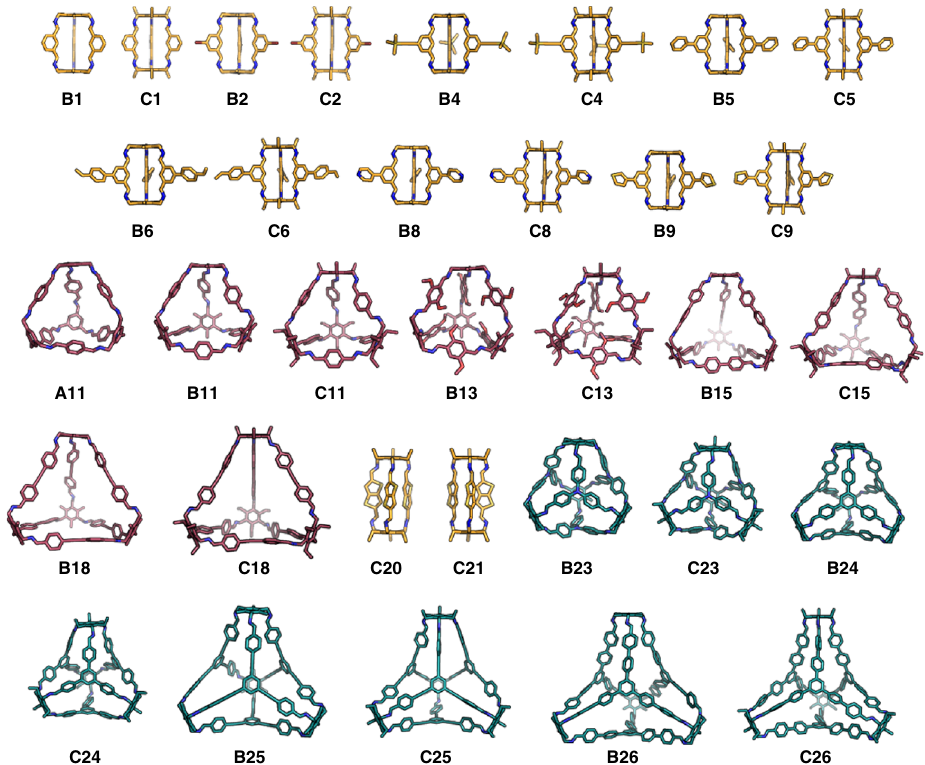
Fig. 4 The 33 cages that formed cleanly in this high-throughput study. Tri 2 Di 3 cages are shown with orange carbons, Tri 4 Di 6 with maroon, and Tri 4 Tri 4 with teal. Remaining atom colouring is as follows; oxygen (red), bromine (brown), boron (pink), silicon and sulphur (yellow), and nitrogen (blue). Hydrogens are omitted. All structures are derived from computational predictions. For cages C20 and C21 , Tri 2 Di 3 cages were formed as shown, rather than the predicted Tri 4 Di 6 cages. All other cages formed the predicted, targeted topology. Supplementary Fig. 4 shows structures for cages that were identi fi ed by solution analysis, but that were either impure or showed incomplete conversion of the starting materials. Supplementary Fig. 3 shows the computed structures for cages that did not form by experiment (red squares in Fig.